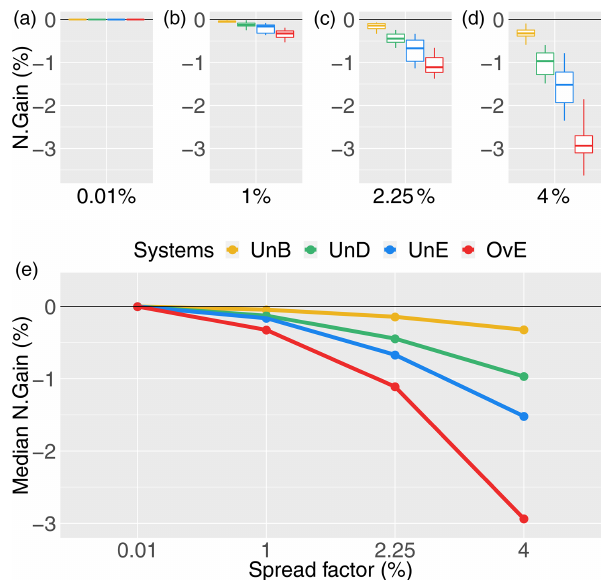
Figure 8. Percentage gain in hydropower revenue (N. Gain in %) for synthetically generated forecasts of different quality: unbiased system (UnB, yellow), underdispersed system (UnD, green), un- derestimating system (UnE, blue) and overestimating system (OvE, red). Systems are based on ensembles generated with four different spread factors (0.01%, 1%, 2.25%, and 4%). (a–d) Boxplots rep- resent the maximum value, percentiles 75, 50 and 25, and minimum value over the 10 studied catchments. (e) Median